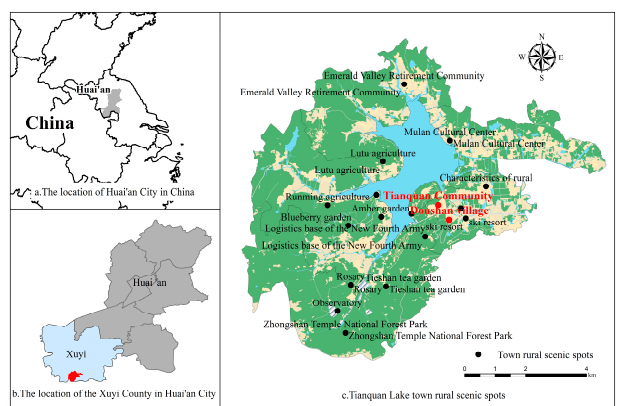
Figure 3. The geographical locations of research areas.